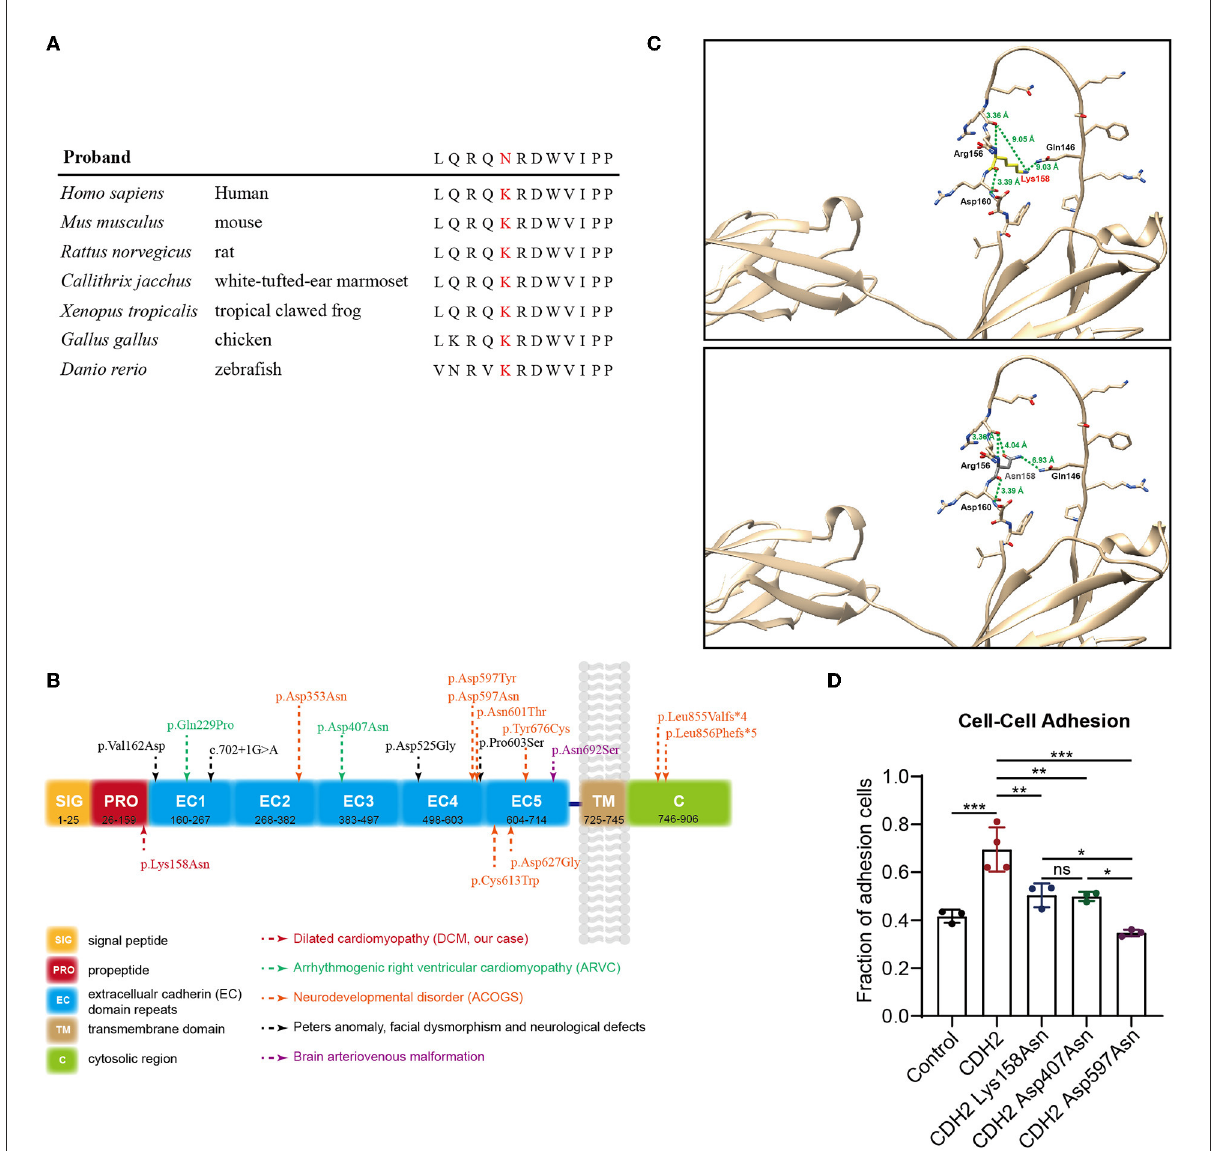
FIGURE2 Genetic analysis and functional tests of the de novo variant (c.474G > C/p.Lys158Asn) in CDH2 . (A) Sequence alignment of human CDH2 and other species shows the conservation of the affected residue (p.Lys158Asn). (B) Schematic representation of the topological domains of CDH2 protein. Rare heterozygous CDH2 variants linked to ARVC, ACOGs, Peters anomaly, and brain arteriovenous malformation were annotated. (C) The structure of CDH2 and Lys158Asn mutant. The human CDH2 protein structure was modeled from the “AlphaFold Protein Structure Database” (AlphaFoldDB: P19022, https://alphafold.com/). The structure was aligned with the solution structure of neural cadherin prodomain (PDB: 1OP4) and analyzed using UCSF chimera. (D) The cell-cell adhesion efficiency of the wild-type and CDH2 variations. The significance value was set as p < 0.05 (*), p < 0.01 (**), and p < 0.001